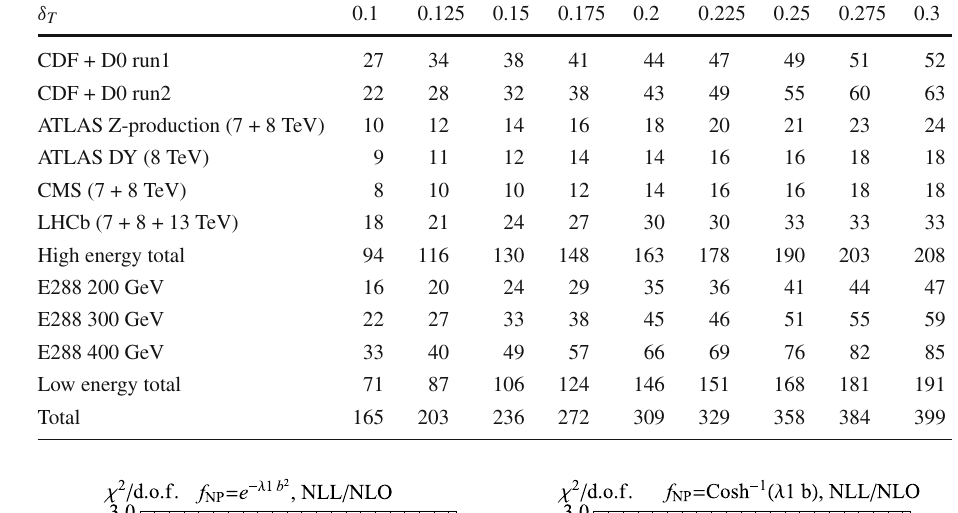
Fig. 3 The δ T dependence of the value of χ 2 / d . o . f . for some one-parameter models. The value of the parameter coming from the fit is also shown together with systematic